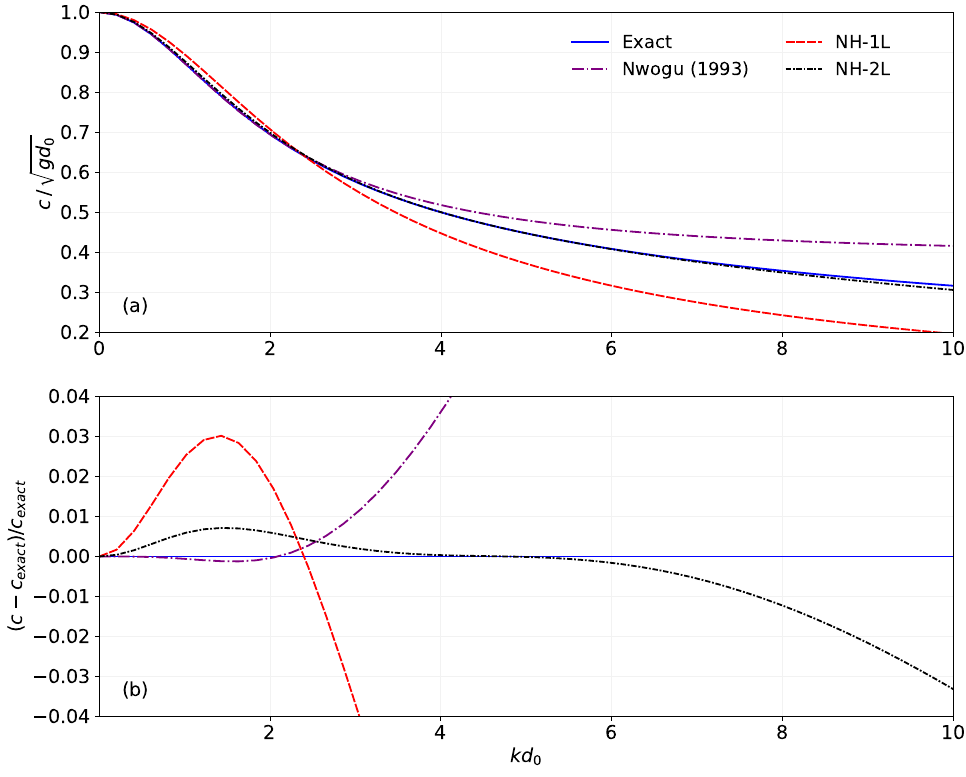
(cid:112) gd 0 as a function of kd 0 . ( b ) Relative error of the